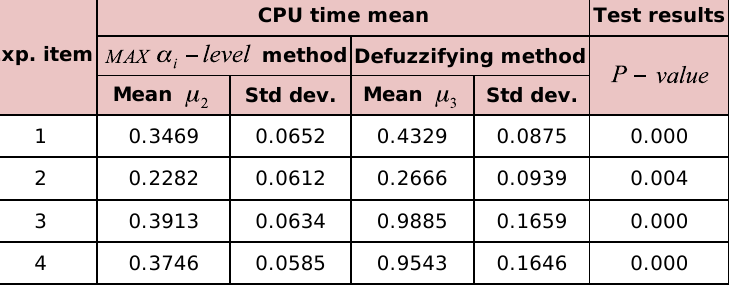
Table 3. “Mean of CPU